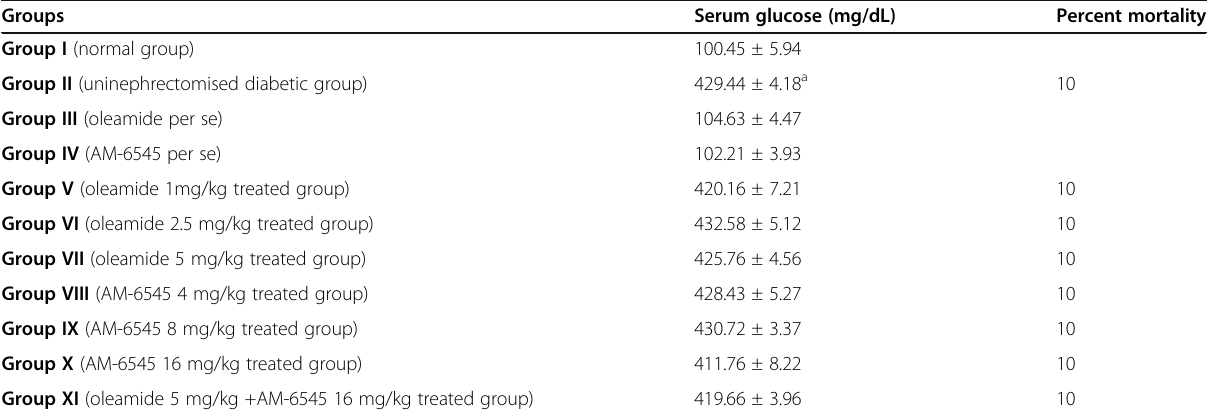
Table 2 Serum blood glucose levels in various groups Groups Serum glucose (mg/dL) Group I (normal